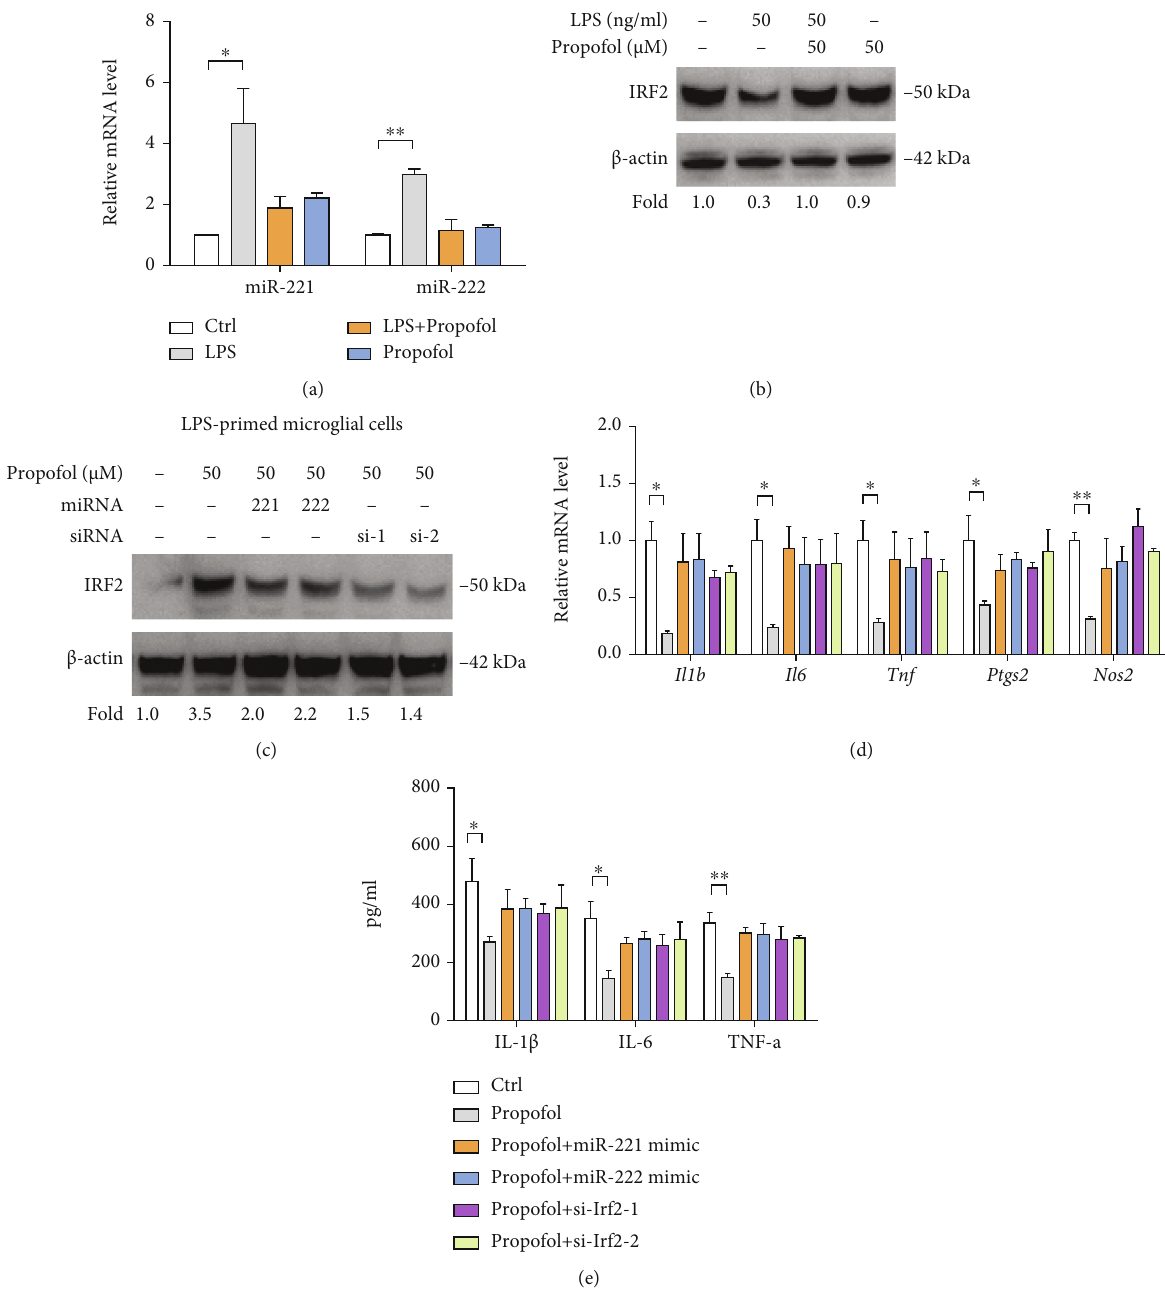
Figure 6: Propofol-miR-221/222-IRF2 axis is involved in primary microglia activation. (a) miR-221 and miR-222 expression in primary microglia upon treatment with LPS and/or propofol were analyzed by real-time qPCR ( n = 3 ). (b) IRF2 protein expression in primary microglia upon treatment with LPS and/or propofol was analyzed by Western blotting; β -actin was loaded as a control. (c) IRF2 protein expression in LPS-primed primary microglia upon treatment with propofol, miR-221/222 mimics, and/or IRF2 siRNAs was analyzed by Western blotting; β -actin was loaded as a control. (d) The e ff ects of propofol, miR-221/222 mimics, and/or IRF2 siRNAs on the mRNA expression of in fl ammatory genes ( Il1b , IL6 , Tnf , Ptgs2 , and Nos2 ) in LPS-primed primary microglia were determined by real-time qPCR analysis ( n = 3 ). (e) The e ff ects of propofol, miR-221/222 mimics, and/or IRF2 siRNAs on the level of in fl ammatory cytokines (IL-1 β , IL- 6, and TNF- α ) in conditioned medium from LPS-primed primary microglia were analyzed by ELISA ( n = 3 ). ∗ p < 0 : 05 and ∗∗ p < 0 : 01